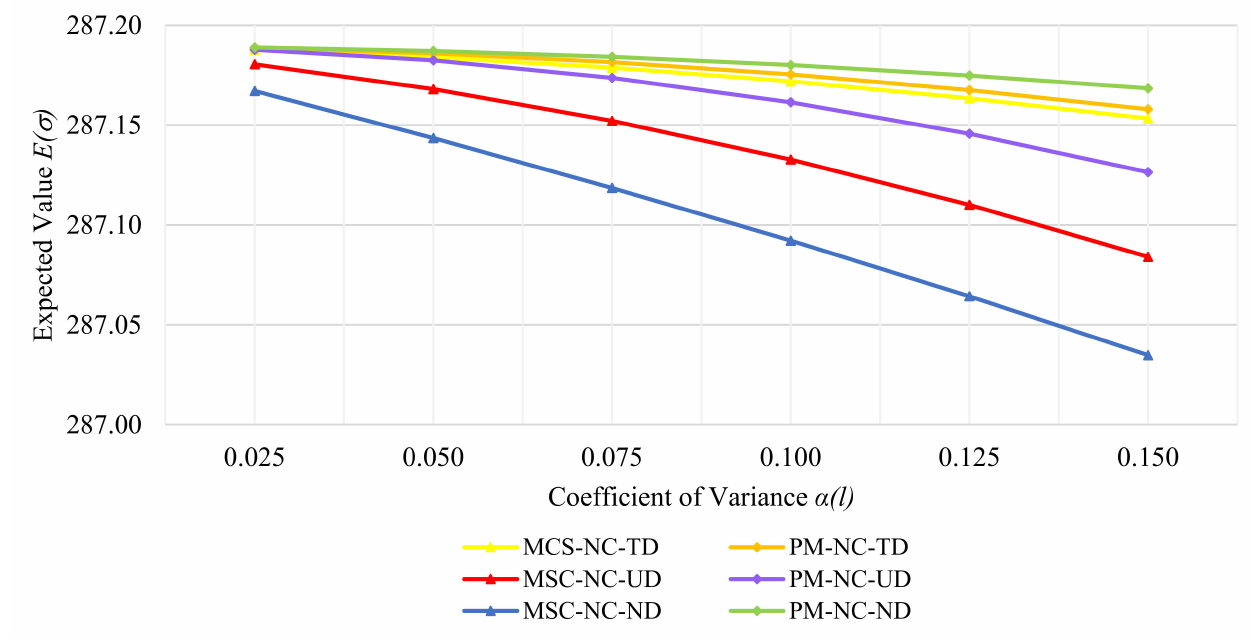
Figure 13. Expected Value E in the ULS.